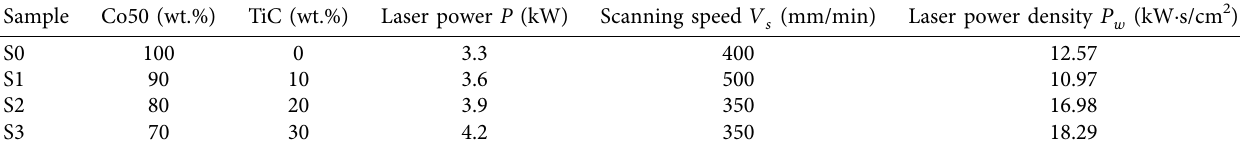
Table 3: Technical parameters and samples surface of the LC method applied in the experiment. Sample